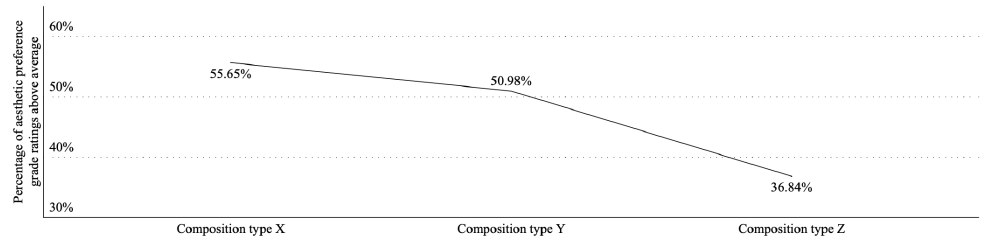
Figure 9. Distribution of aesthetic preferences in relation to the composition type of the facade.